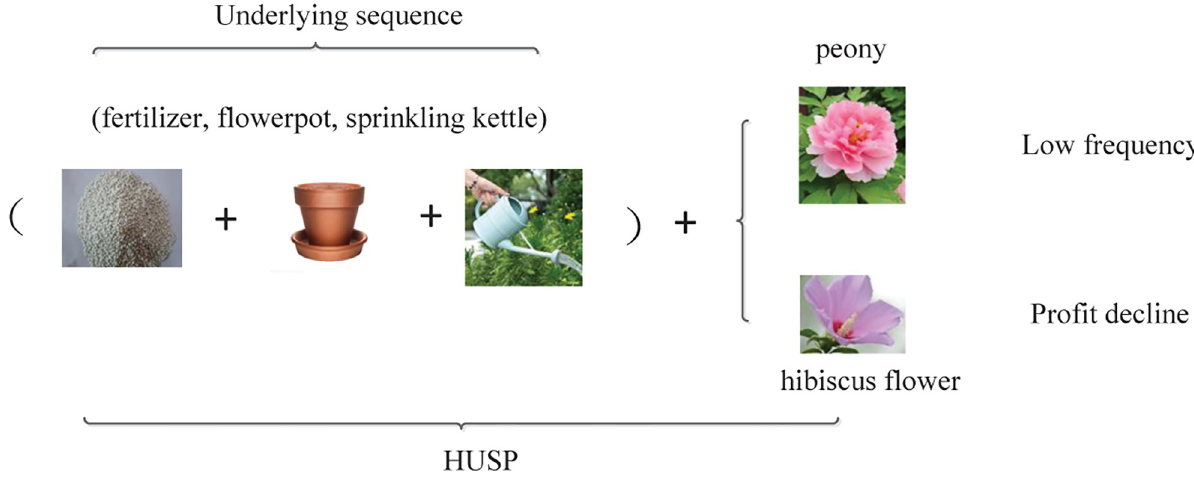
Fig 1. An example of HUSP sharing the same underlying